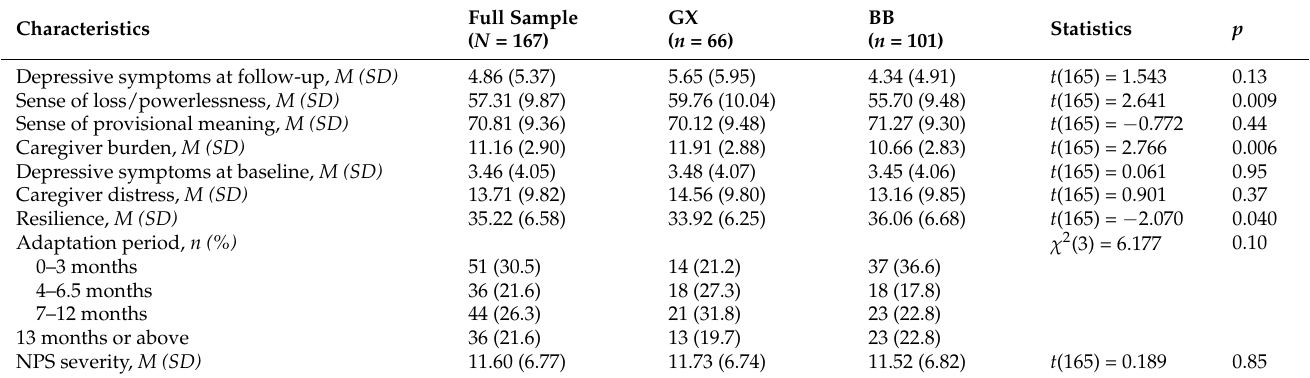
Table 2. Differences in outcomes of interest among caregivers from two generations ( N =